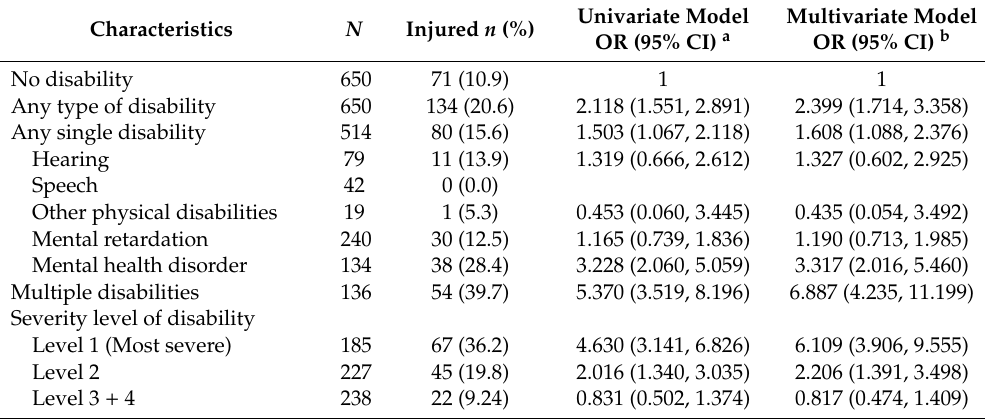
Table 4. Multivariable logistic regression results of the type and severity of disability on DSH among children with disabilities in Beijing,